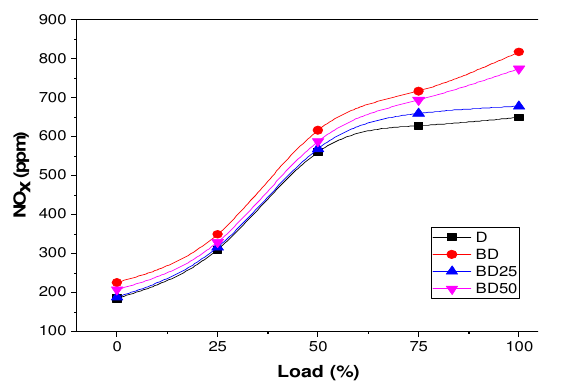
Fig. 7: Engine load variation with NOx emission with diesel and Jatropha biodiesel blends.